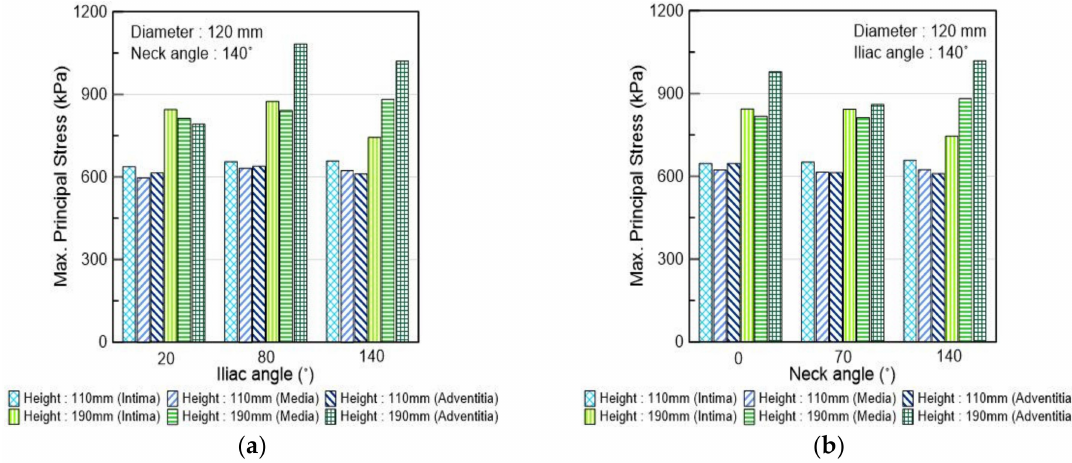
Figure 8. Maximum principal stress according to ( a ) iliac angle and ( b ) neck